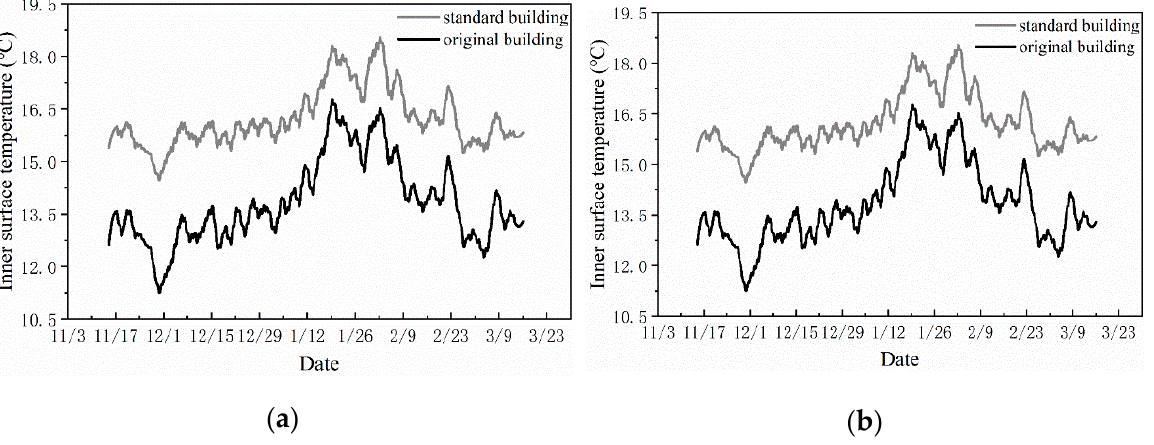
Figure 6. The dynamically inner surface temperature: ( a ) living room and ( b ) south facing bedroom.